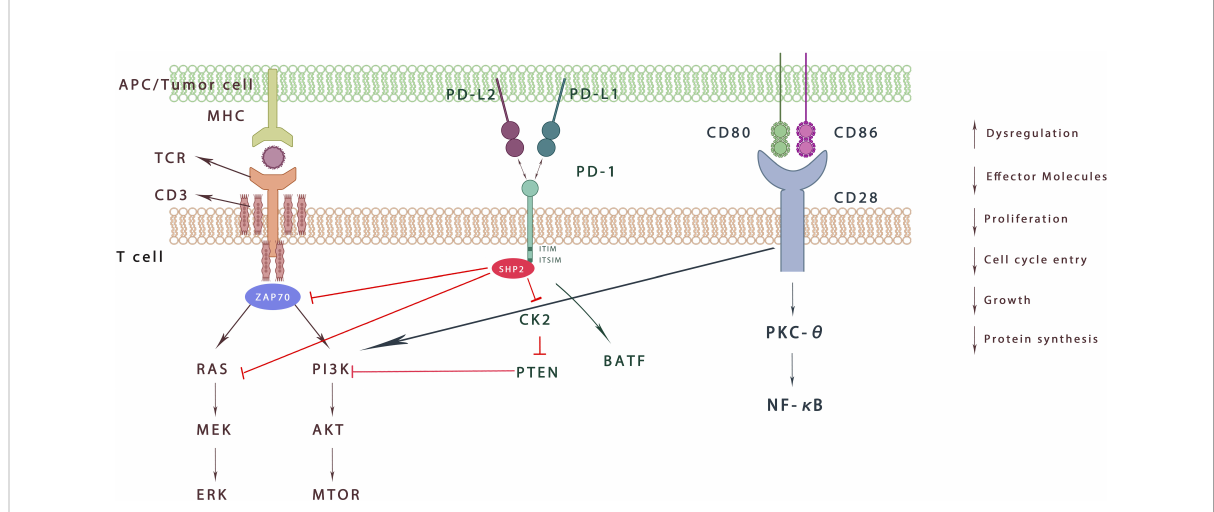
FIGURE 1 Effect of PD-1 signaling on T cells. When binding to PD-L1 and PD-L2, ITSM is phosphorylated and recruits SHP-2, which inhibits downstream signaling through dephosphorylated kinases. It further weakens ZAP70 phosphorylation and decreases the RAS-MEK-ERK/PI3K Akt mTOR pathway. In addition, PD-1 activation increases the expression of BATF. Overall, PD-1 signaling aggravates the imbalance of immune microenvironment, inhibits T cell proliferation, decreases effector molecules, and protein